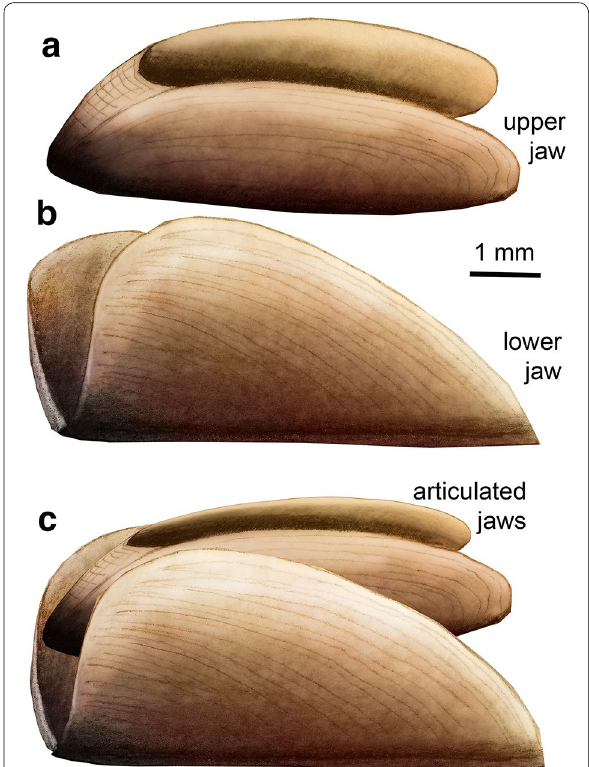
Fig. 6 Reconstructions of the jaws of Leioceras opalinum (Reinecke 1818) from the Aalenian. a upper jaw after PIMUZ 5942. b lower jaw after the specimens shown in Mitta et al. (2015). c articulated jaws; the deep posterior incision allows movement in the body chamber where the preceding whorl restricts the whorl